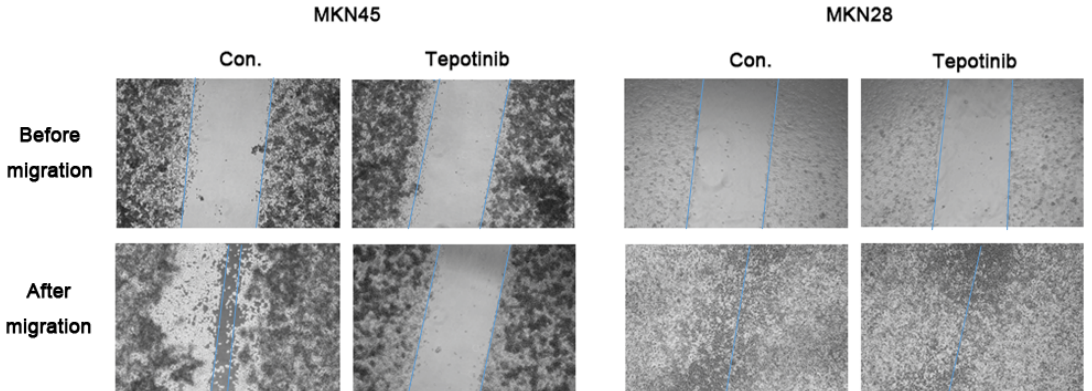
Figure 2. A wound-healing assay was used to assess the effect of tepotinib on the migration abilities of MKN28 and MKN45 cells. Tepotinib-treated MKN45 cells showed suppressed migration ability compared with tepotinib-treated MKN28 cells. Con, non-treated control cell lines.